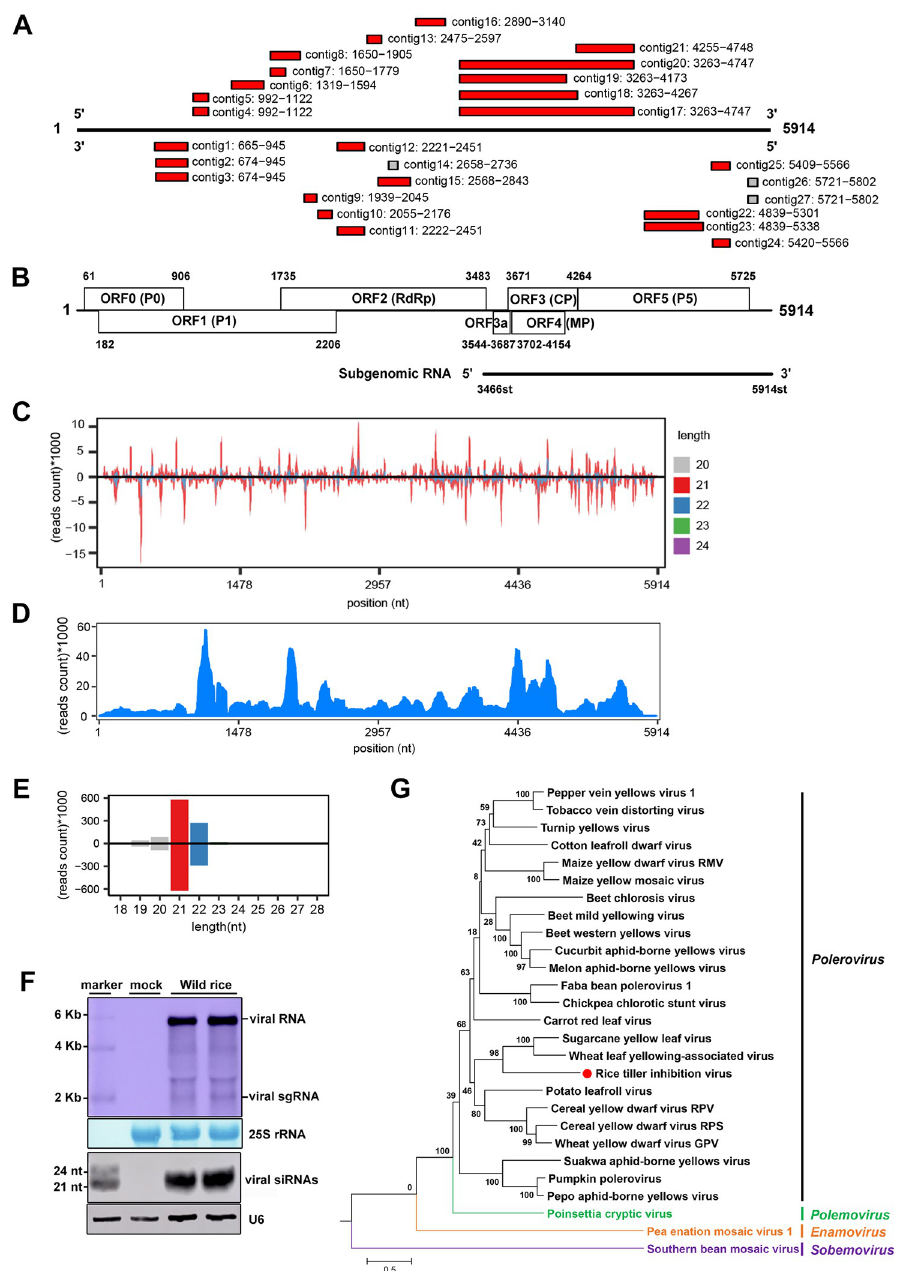
Fig 1. The discovery of RTIV in Asian wild rice colonies. (A) Assembled RTIV contigs from vdSAR. (B) Schematic representation of the RTIV genome and subgenomic RNA, with the six main ORFs (ORF 0–5) and a small ORF3a. (C) Small RNA-Seq of Wild-rice individual, the single-nucleotide resolution maps of the positive- and negative-strand 20- 24nt vsiRNAs in the viral genome from the sequenced small RNA pool. (D) The RTIV genome maps of RNA-seq reads sequenced from colony no. 9 wild rice plants. (E) Size distribution of the positive- and negative-strand small RNA reads derived from RTIV. (F) Northern blot detection of the viral genomic/subgenomic (sg) RNAs (top 2 panels) and vsiRNAs (bottom 2 panels) in two individual wild rice plants from colony no. 9. 25S rRNA was stained and U6 was probed to show equal loading. (G) Phylogenetic relationship of RTIV with known members of Polerovirus and other genera in the family Solemoviridae based on the